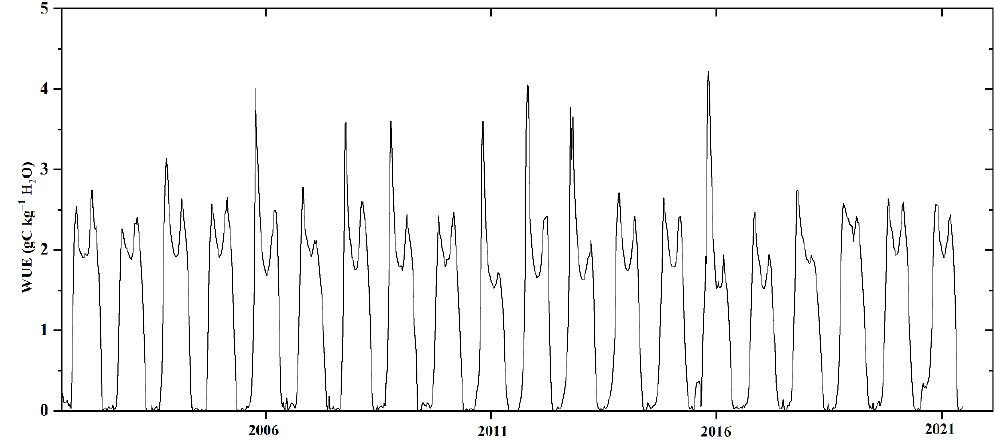
Figure 1. Example of WUE changes for a cropland pixel ( 38°11′N, 102°38′E ) during 2002 – 2021.